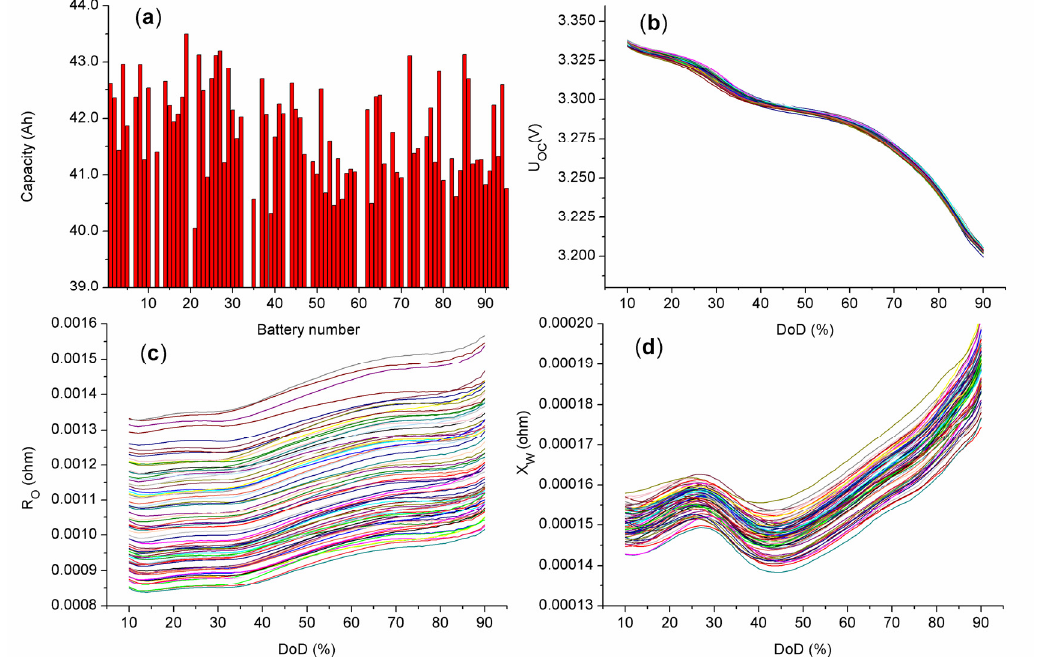
Figure 11. The characteristic parameters after preprocess ( a ) Q ; ( b ) U OC ; ( c ) R O ; ( d ) X W